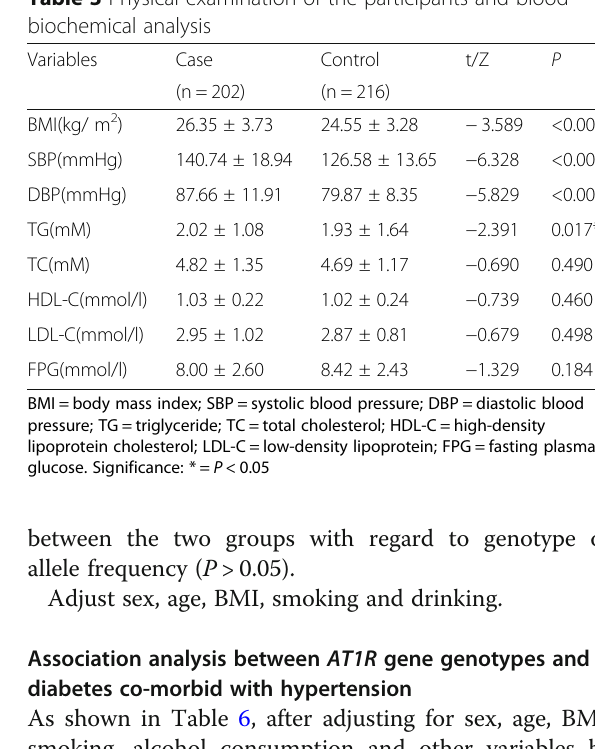
Table 5 Genotypic frequency of AT1R